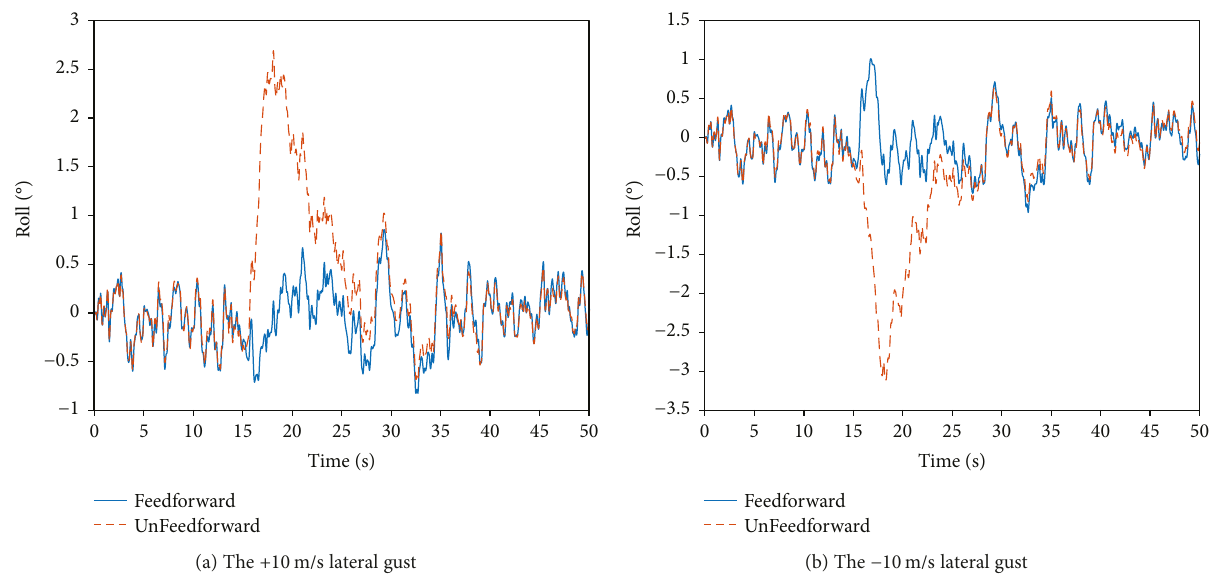
Figure 8: The feedforward and unfeedforward rolling motion control with the nonlinear 6-DOF model of the SUAV.